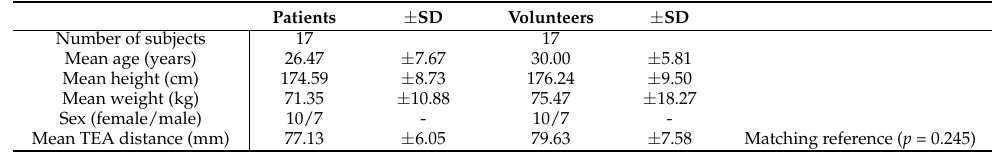
Table 1. Overview of the patients’ and volunteers’